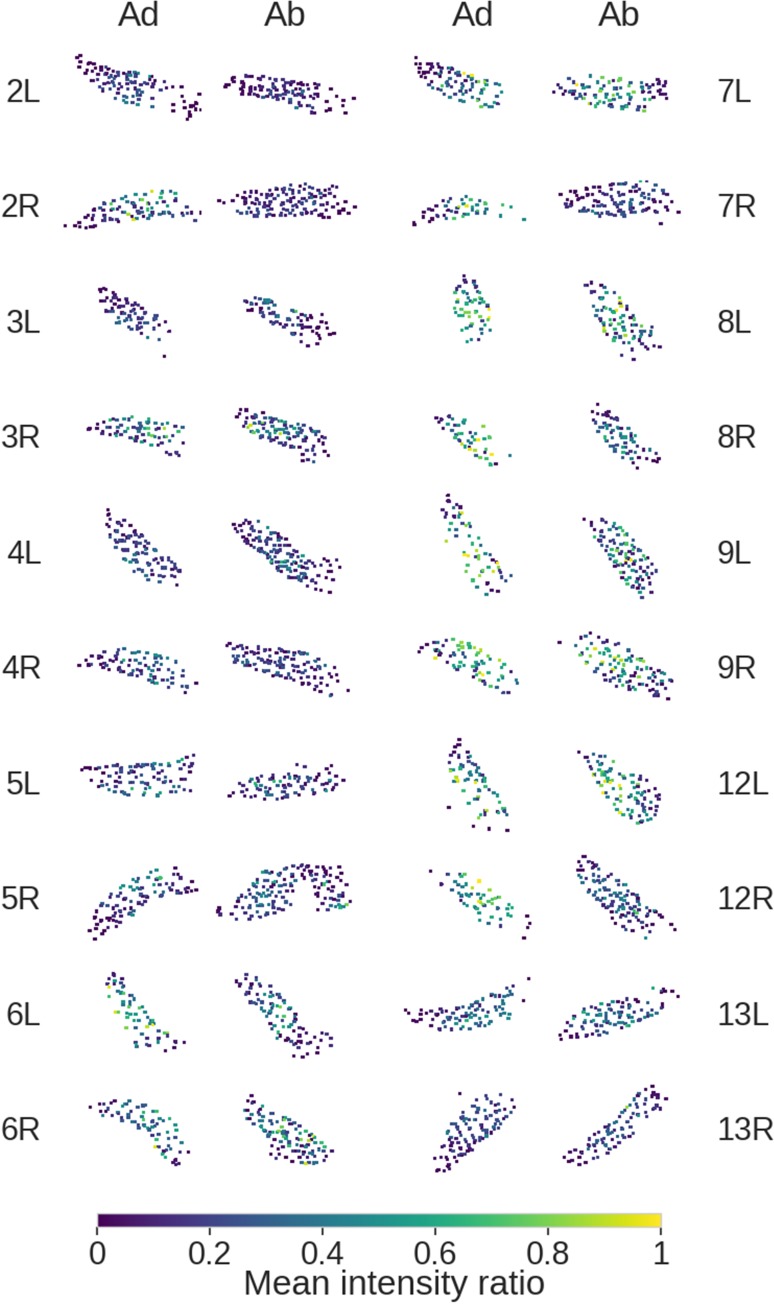
- Spatial distributions of negative auxin readout Maximal Z-projection of segmented nuclear centroids for 10 seedlings (20 leaves) at 4DAS, coloured by signal ratio after filtering.Centroids are shown as 5 × 5 pixel squares. Integers indicate corresponding seedling. L, Left leaf. R, Right leaf. Ad, axaxial; Ab, abaxial.